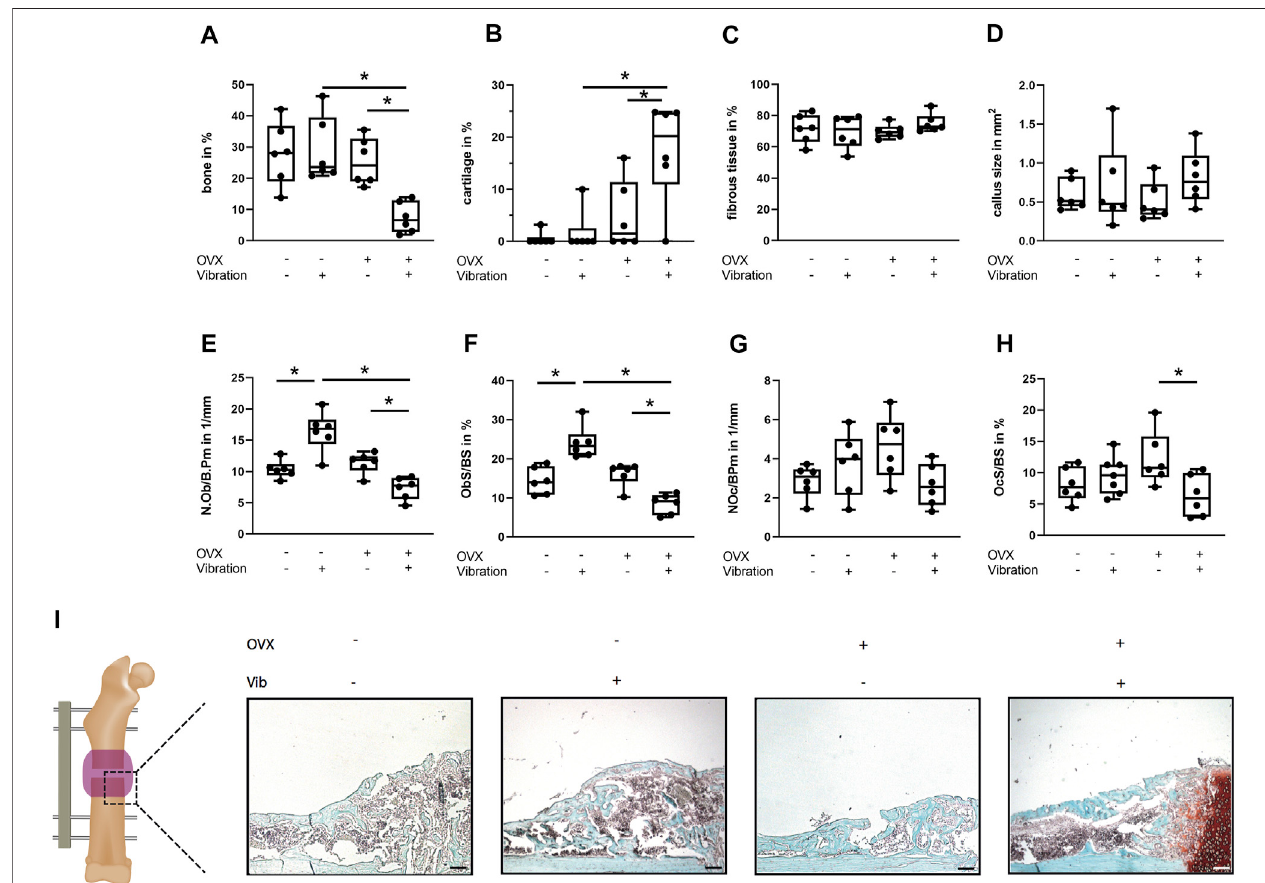
FIGURE 5 | Histomorphometrical analysis of the fracture gap in ER α fl / fl ; Runx2Cre mice on day 21. Paraf fi n sections of fractured femurs were stained with Safranin O and histomorphometricalanalysiswasperformed todetermine (A) relativebone area, (B) cartilagearea, (C) relative fi broustissue areaand (D) callussize. (E) Numberof osteoblasts per bone perimeter (NOb/BPm) and (F) osteoblast surface per bone surface (ObS/BS) in the fracture gap. (G) Number of osteoclasts per bone perimeter (NOc/BPm) and (H) osteoclast surface per bone surface (OcS/BS). (I) Representative images from the fracture callus at day 21 after surgery stained with Safranin O. Scale bar (cid:1) 100 μ m. Data are shown as box-and-whisker plots (with median and interquartile range) from max. to min., showing all data points. *indicates signi fi cant effects with p ≤